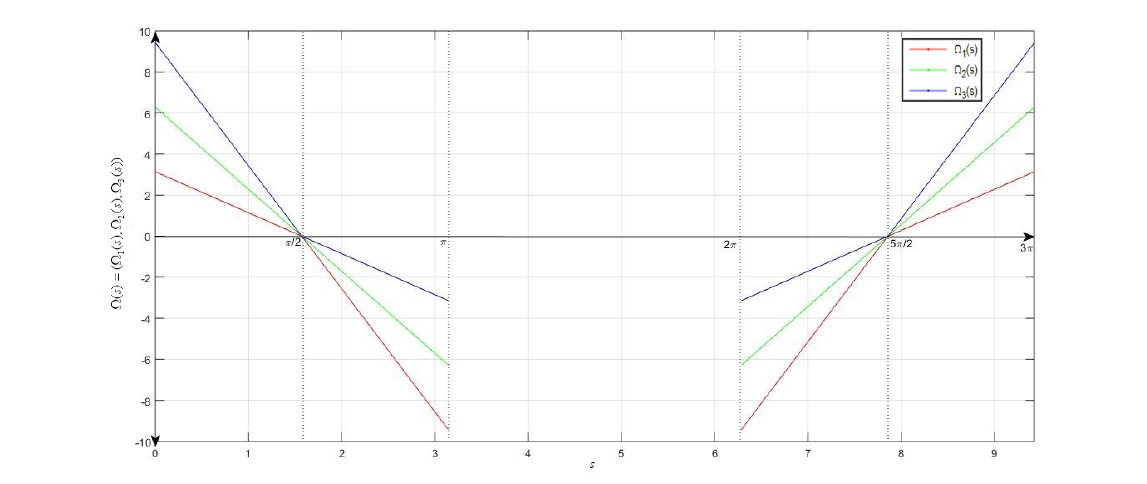
Figure 3. Graphical Representation of Ω ( s ) in Example 3.